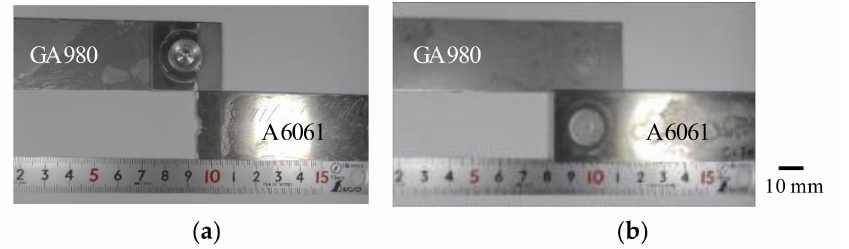
Figure 13. Examples of general views of fractured joints after the tensile shear fatigue test. ( a ) A6061 matrix fracture (welding time: 9 s, load amplitude: 2.7 kN, number of cycles to failure: 98,303 cycles) and ( b ) interfacial fracture (welding time: 10 s, load amplitude: 4.0 kN, number of cycles to failure: 10,165